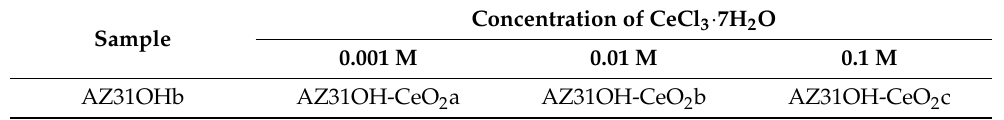
Table 2. Synthesis parameters of CeCC coatings on AZ31-Mg alloy.